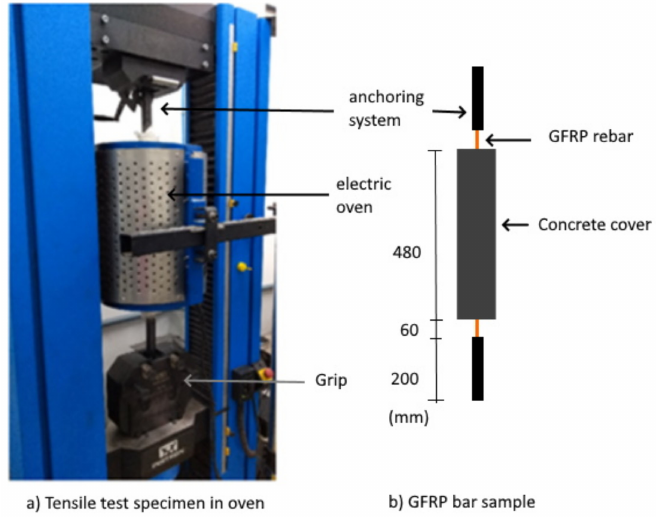
Figure 3. Tensile test setup: ( a ) GFRP bar specimen in oven and ( b ) GFRP bar sample with concrete